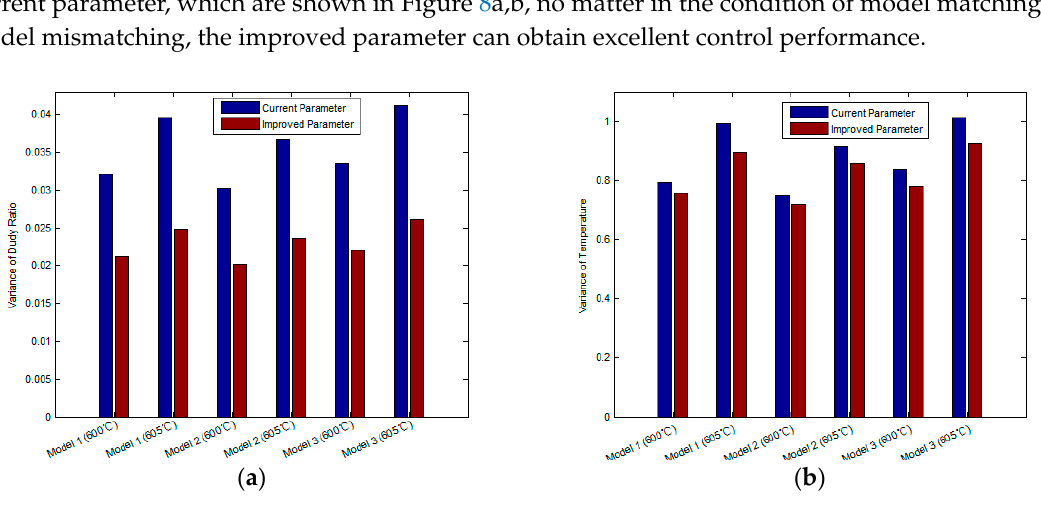
Figure 7. ( a ) A comparison of the improved parameter and the current parameter (Model 1) . ( b ) A comparison of the improved parameter and the current parameter (Model 2). ( c ) A comparison of the improved parameter and the current parameter (Model 3).